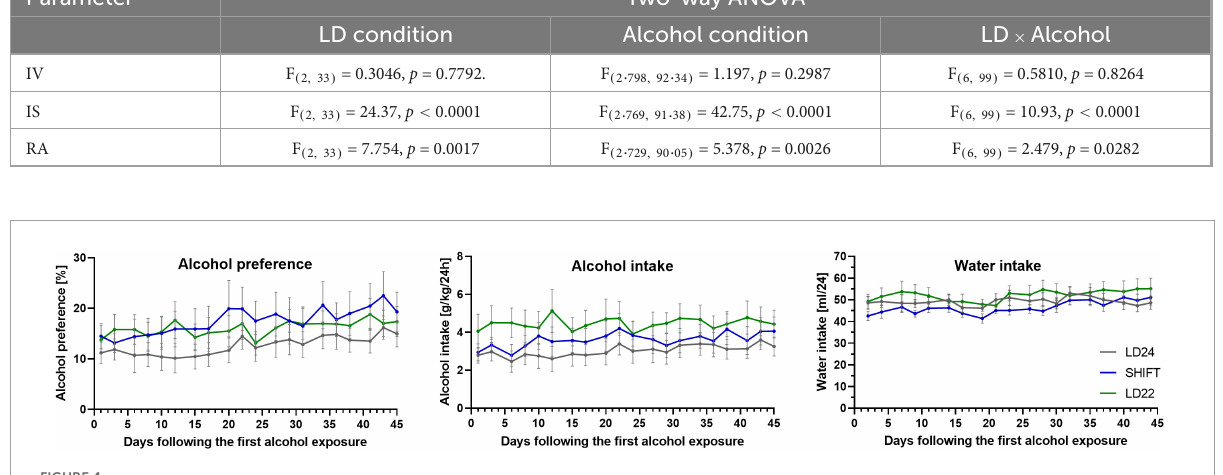
Frontiers in Behavioral Neuroscience